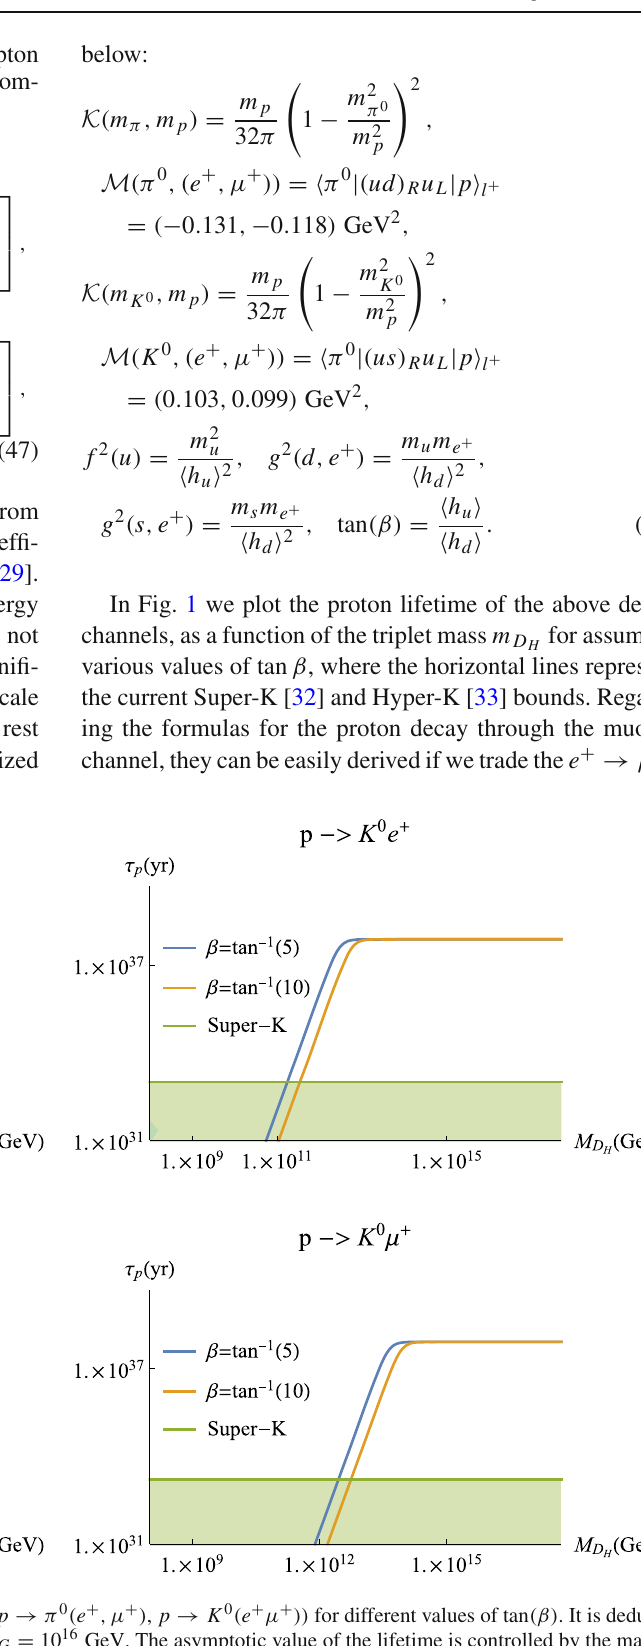
= m ≥ 10 11 GeV , M = 10 16 GeV. The asymptotic value of the lifetime is controlled by the masses G D c H D c H